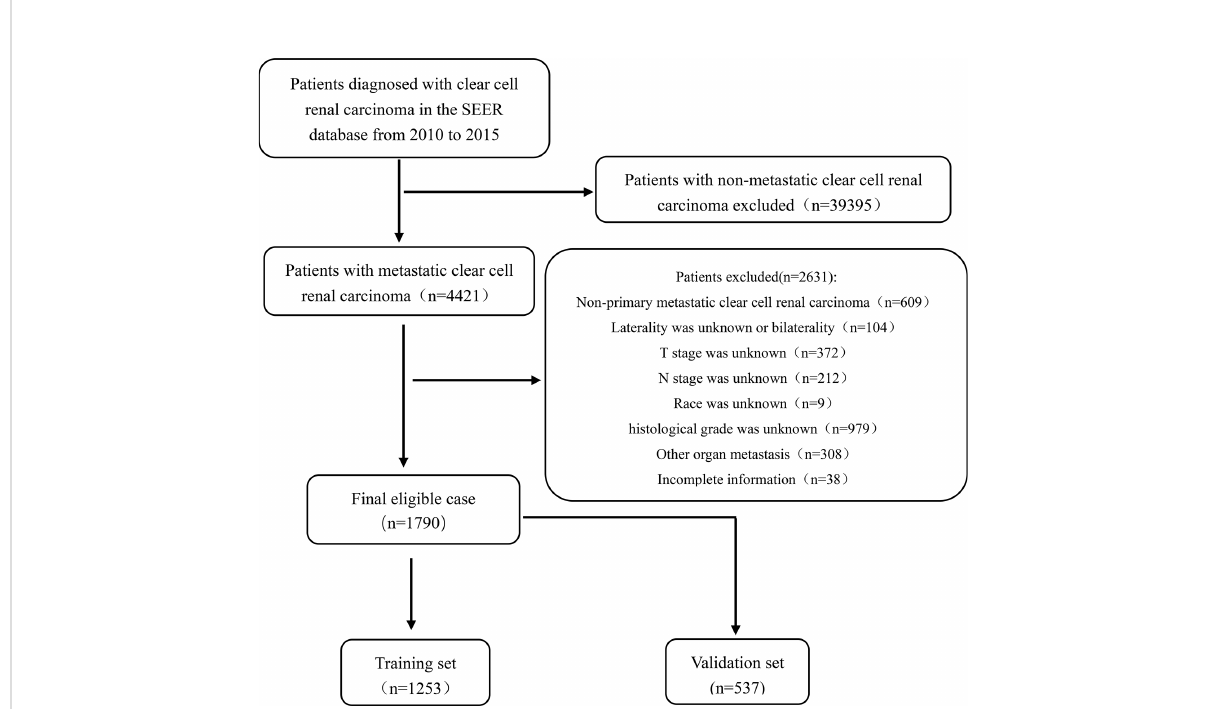
FIGURE 1 Flowchart showing the selection of patients from the SEER database, based on the inclusion and exclusion criteria outlined above; 1,790 patients were included in this